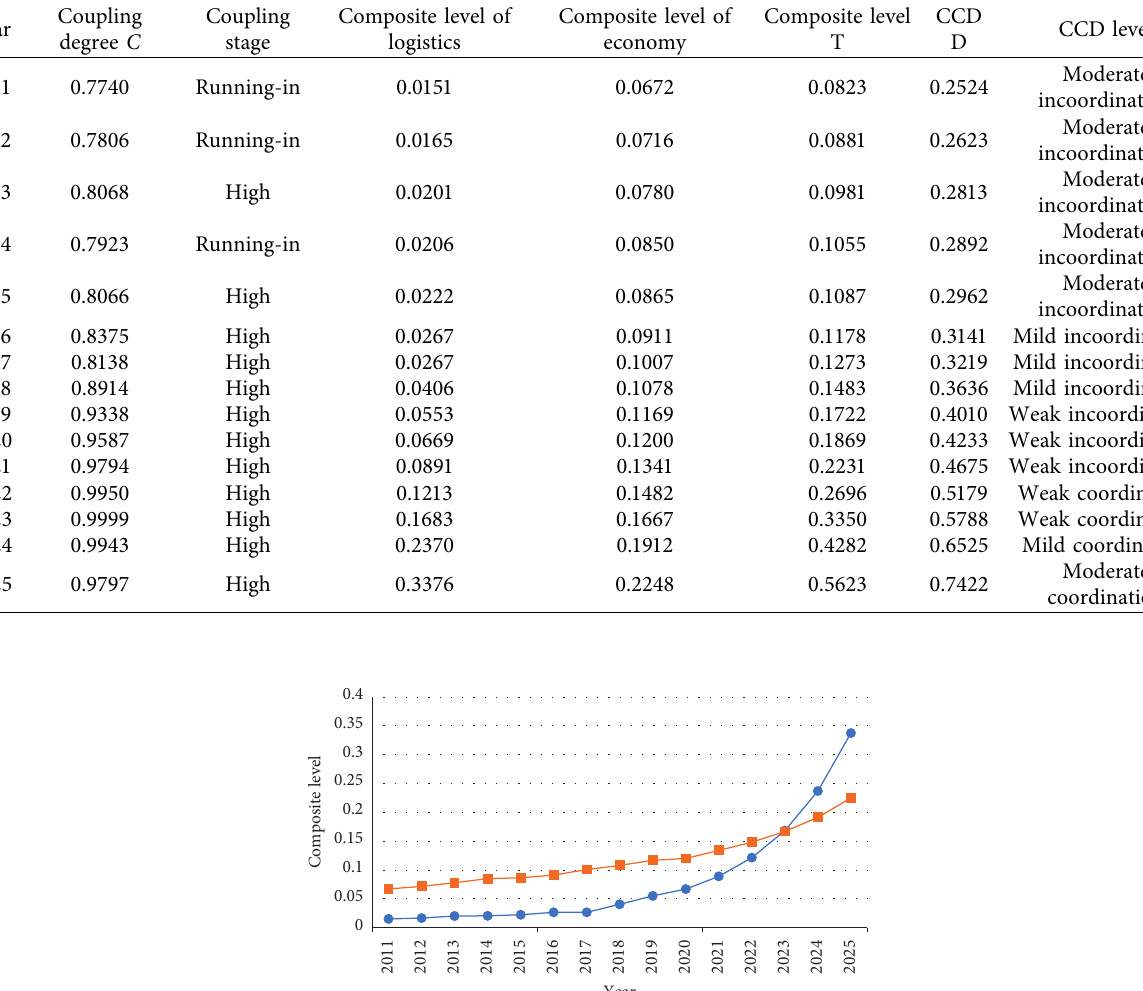
Table 12: CCDs between economy and logistics in Hebei.